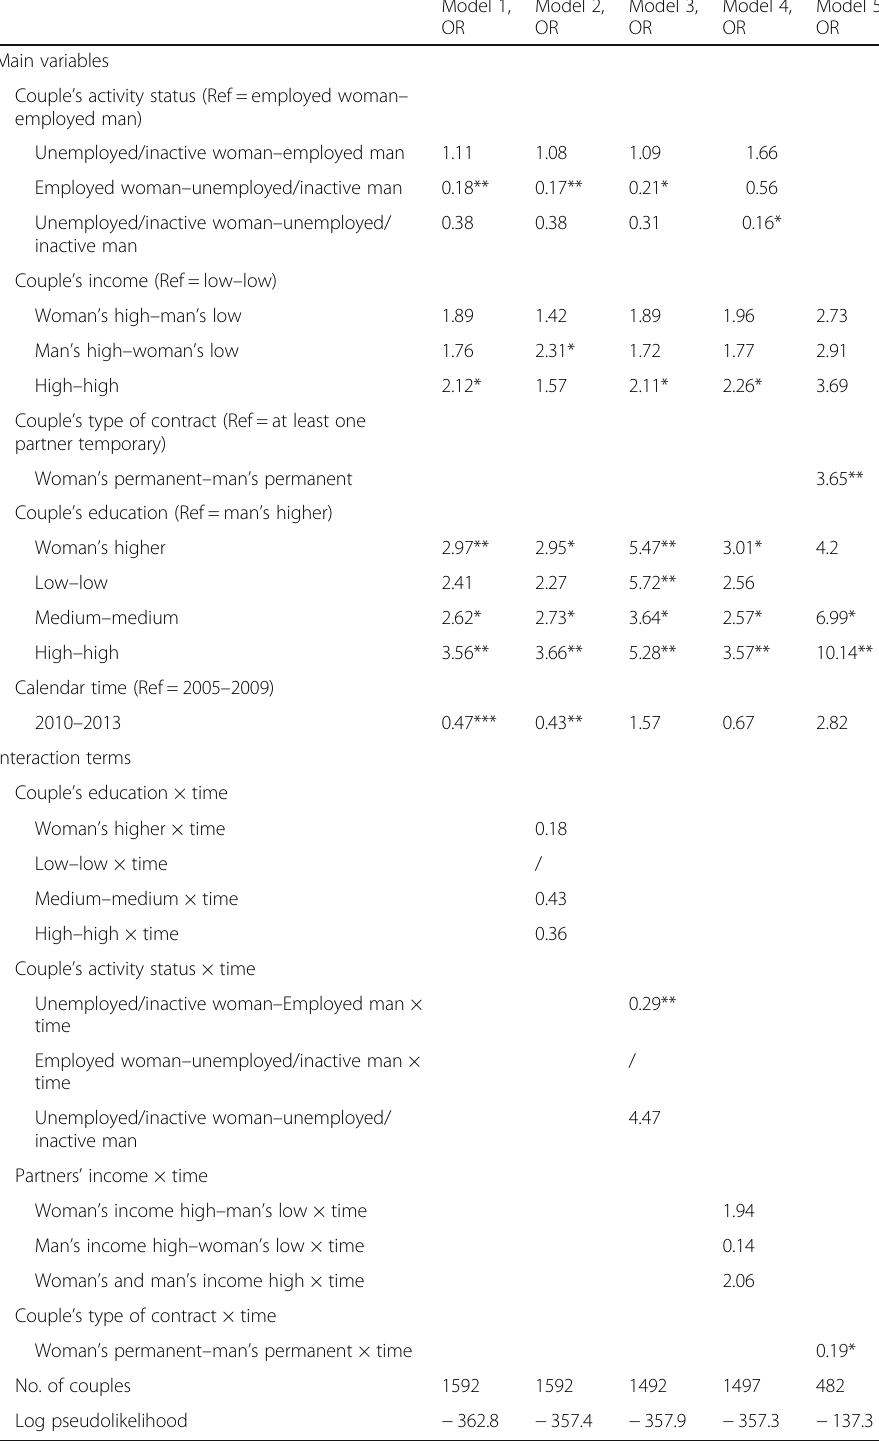
Table 2 Transition to first child in Greece; random effects